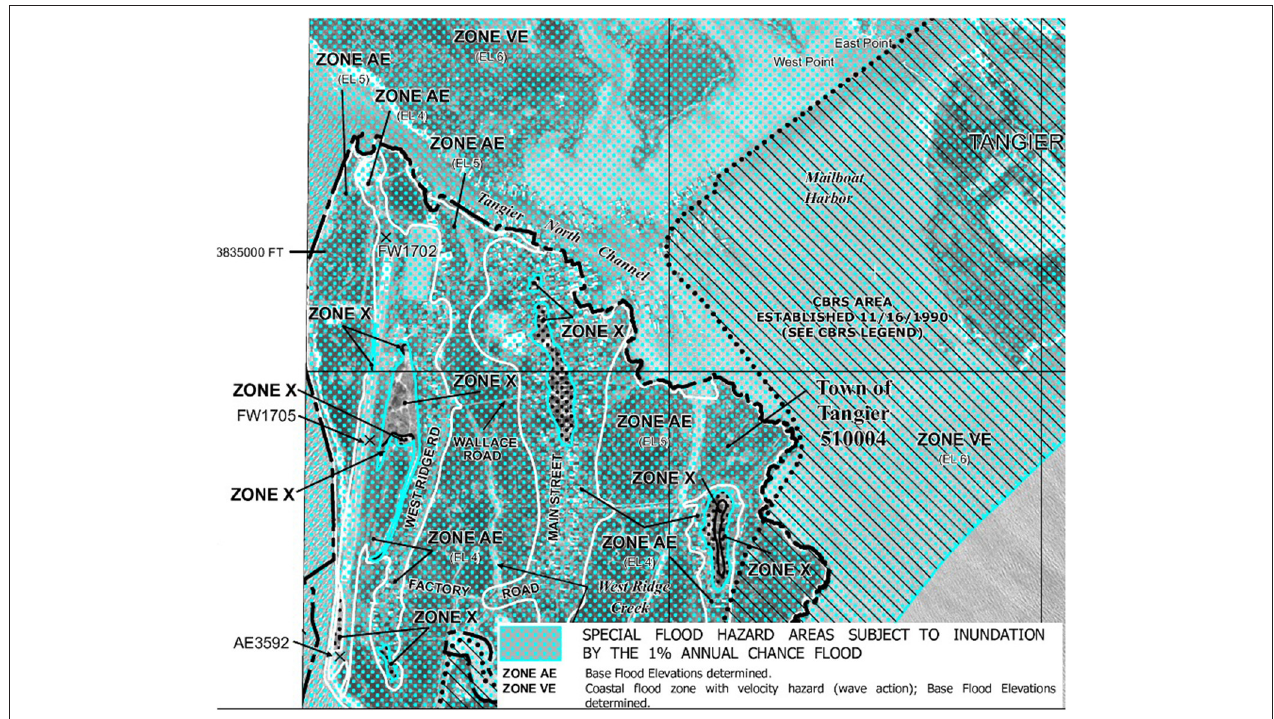
FIGURE 3 | FEMA flood map depicting the highest uplands (flood zone X) of the Town of Tangier in brown, and illustrating the whole island, including the majority of the Town’s uplands is considered to be in flood zone AE. Source: FEMA (2021). Area found within the red rectangle of Figure 1 .